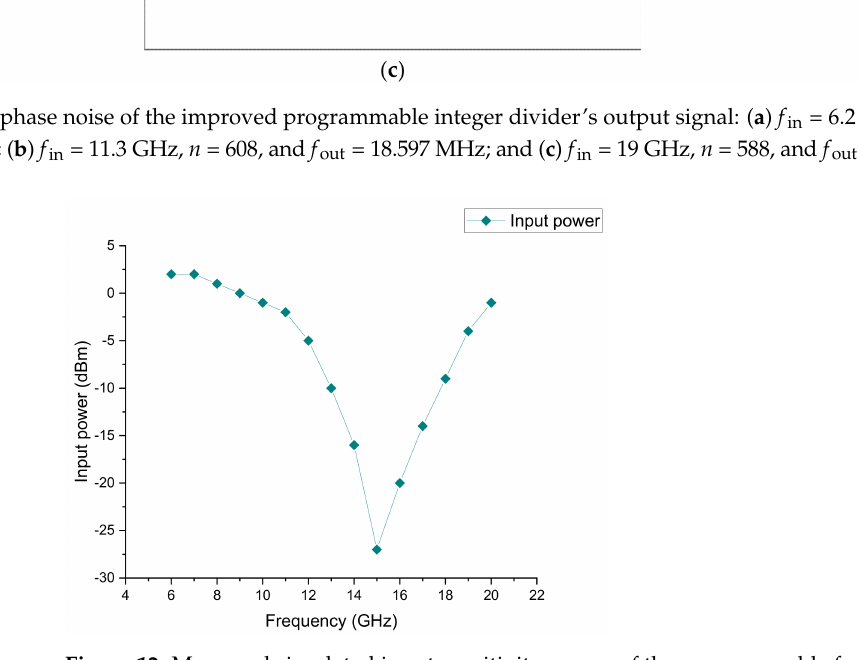
Figure 12. Measured simulated input sensitivity curves of the programmable frequency